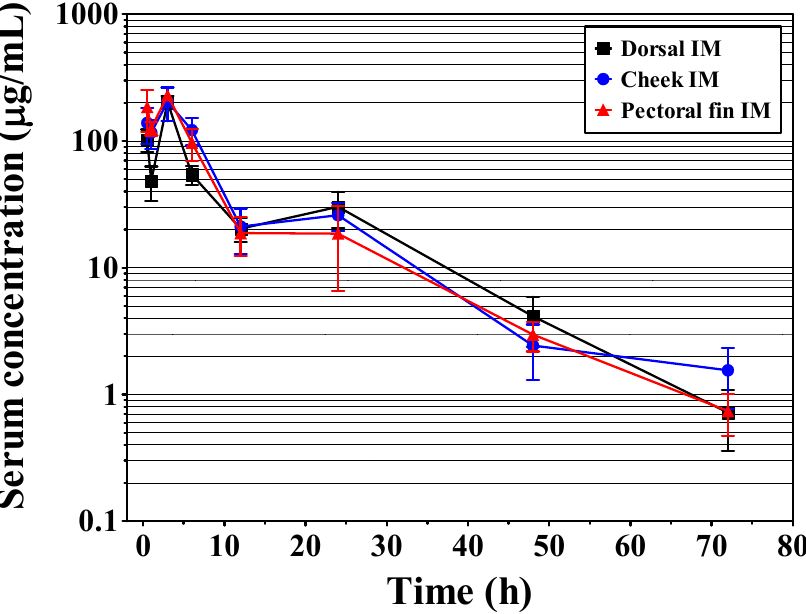
Figure 2. Semilogarithmic of serum concentration-time curves of amoxicillin in olive flounder ( Paralichthys olivaceus ) following intramuscular (dorsal, cheek, and pectoral fin) injection at a dosage of 40 mg/kg. Table 1. Pharmacokinetic parameters of amoxicillin in serum of olive flounder ( Paralichthys oliva ‐ ceus ) following intramuscular (dorsal, cheek, and pectoral fin) injection at a dosage of 40 mg/kg.